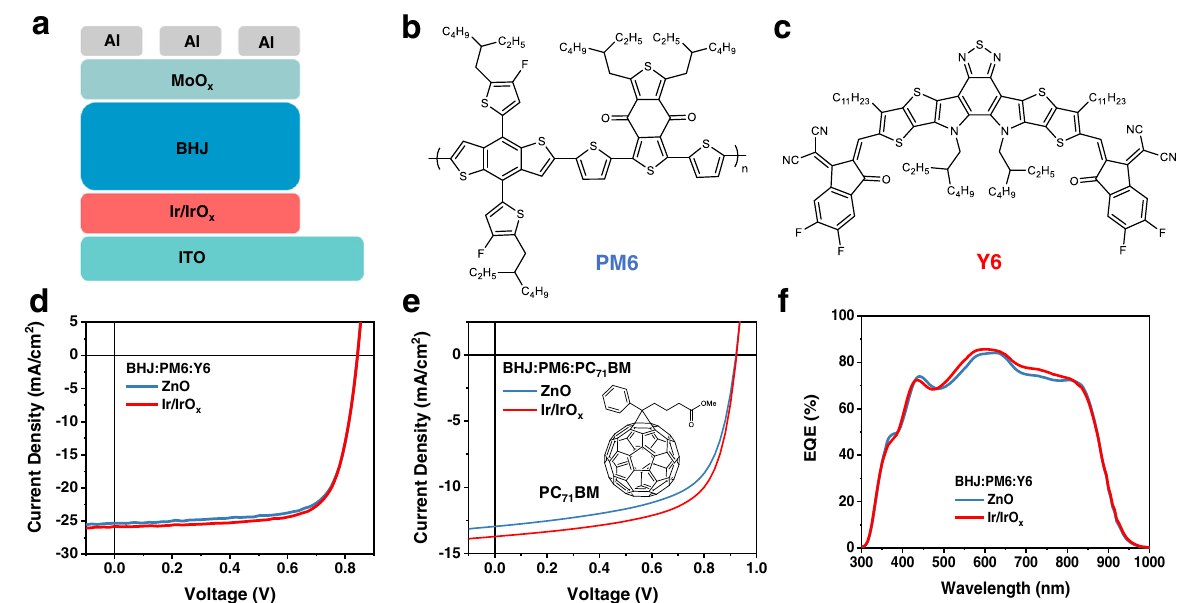
Fig. 2 | Device performance. a The device structure is based on Ir/IrO x nano- particles.Molecularstructures of PM6 ( b )and Y6( c ). J-V characteristicsof PM6:Y6 ( d ) and PM6:PC 71 BM ( e ) devices on different electron-transporting materials.